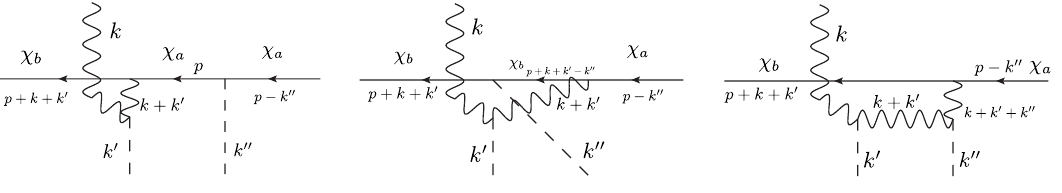
Figure 13 . An example to treat the k + k 0 line as a new \external" line recursively when it has a scalar